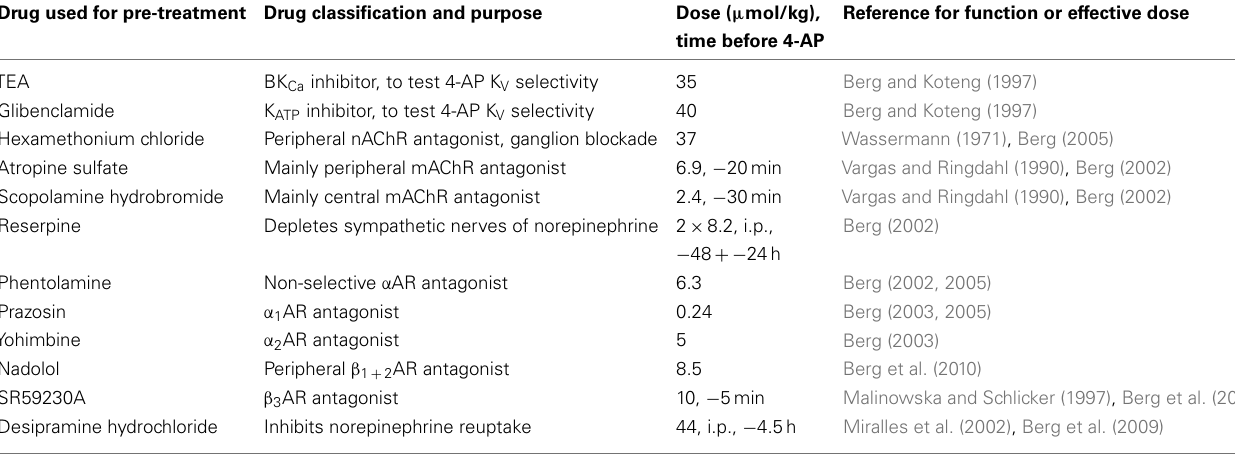
Table 1 | Details on the drugs used for pre-treatment. Drug used for pre-treatment Drug classification and